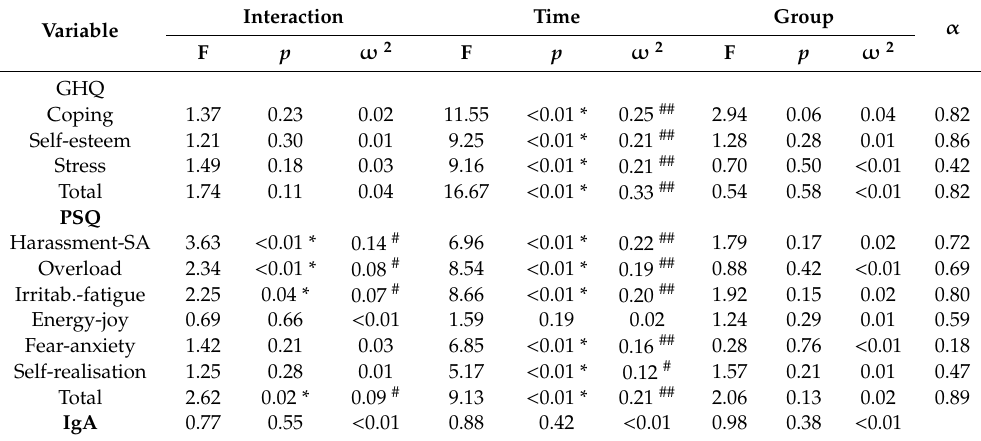
Table 2. Results of the mixed linear model (MLM) for the main e ff ects—group, time and interaction